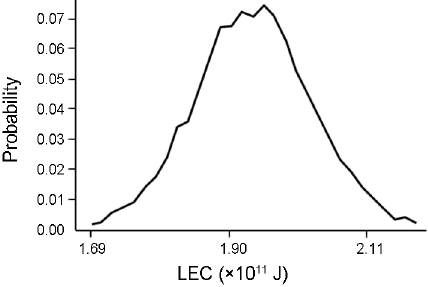
Fig. 14. Lifecycle energy consumption (Probability density function)